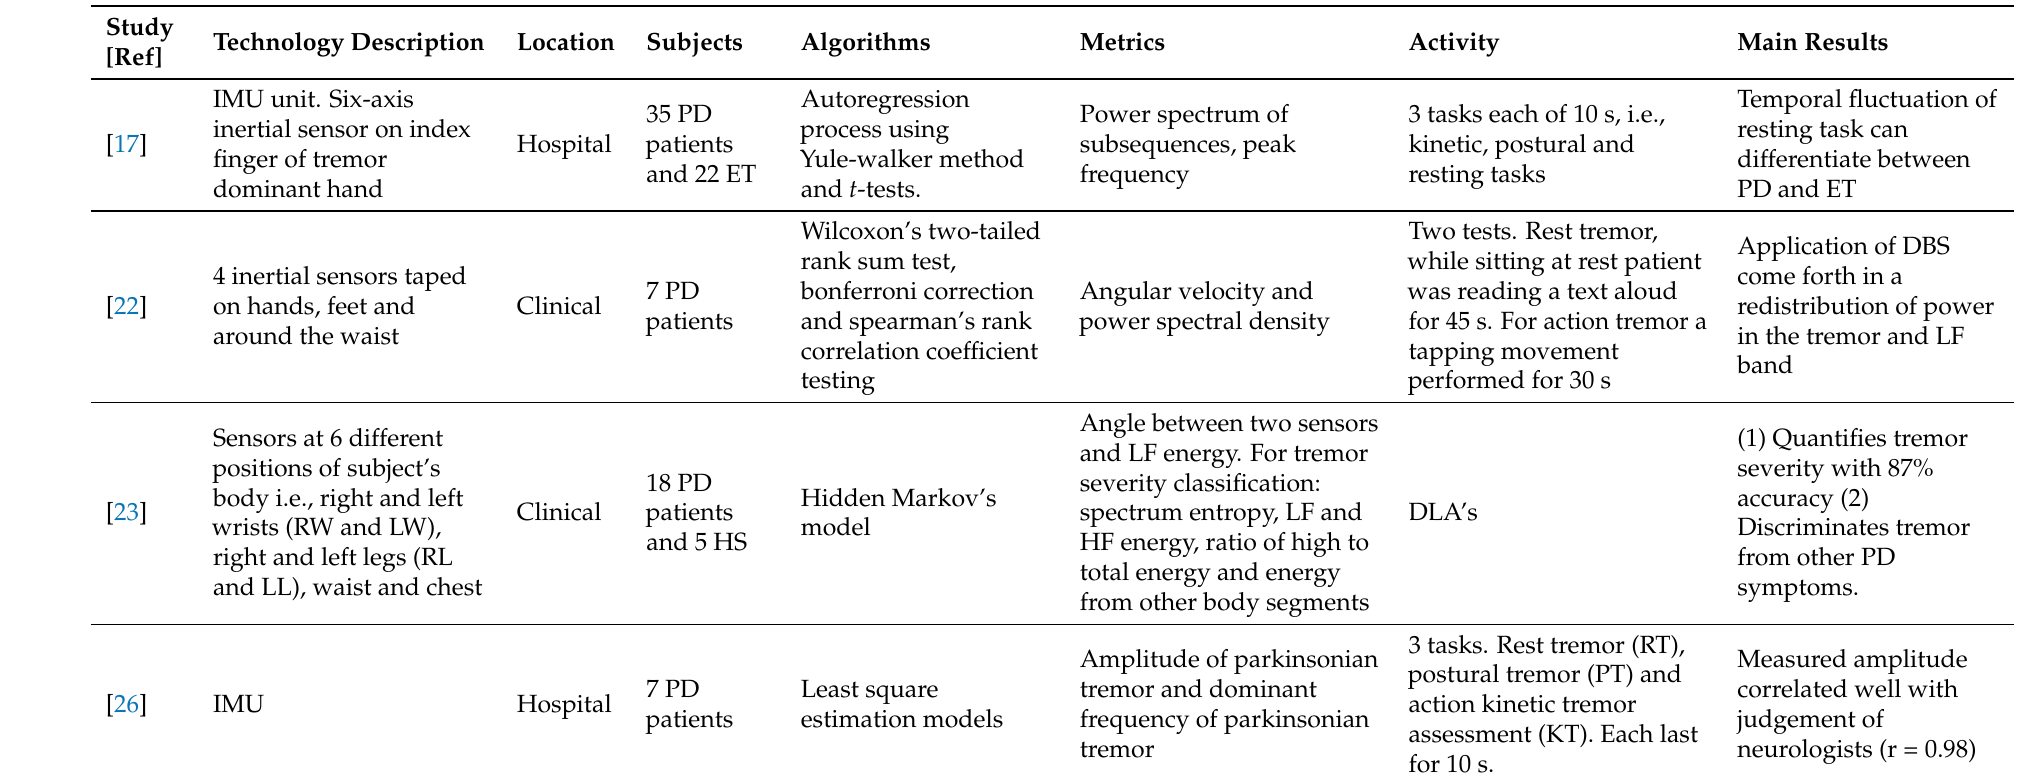
Table 2. Studies on